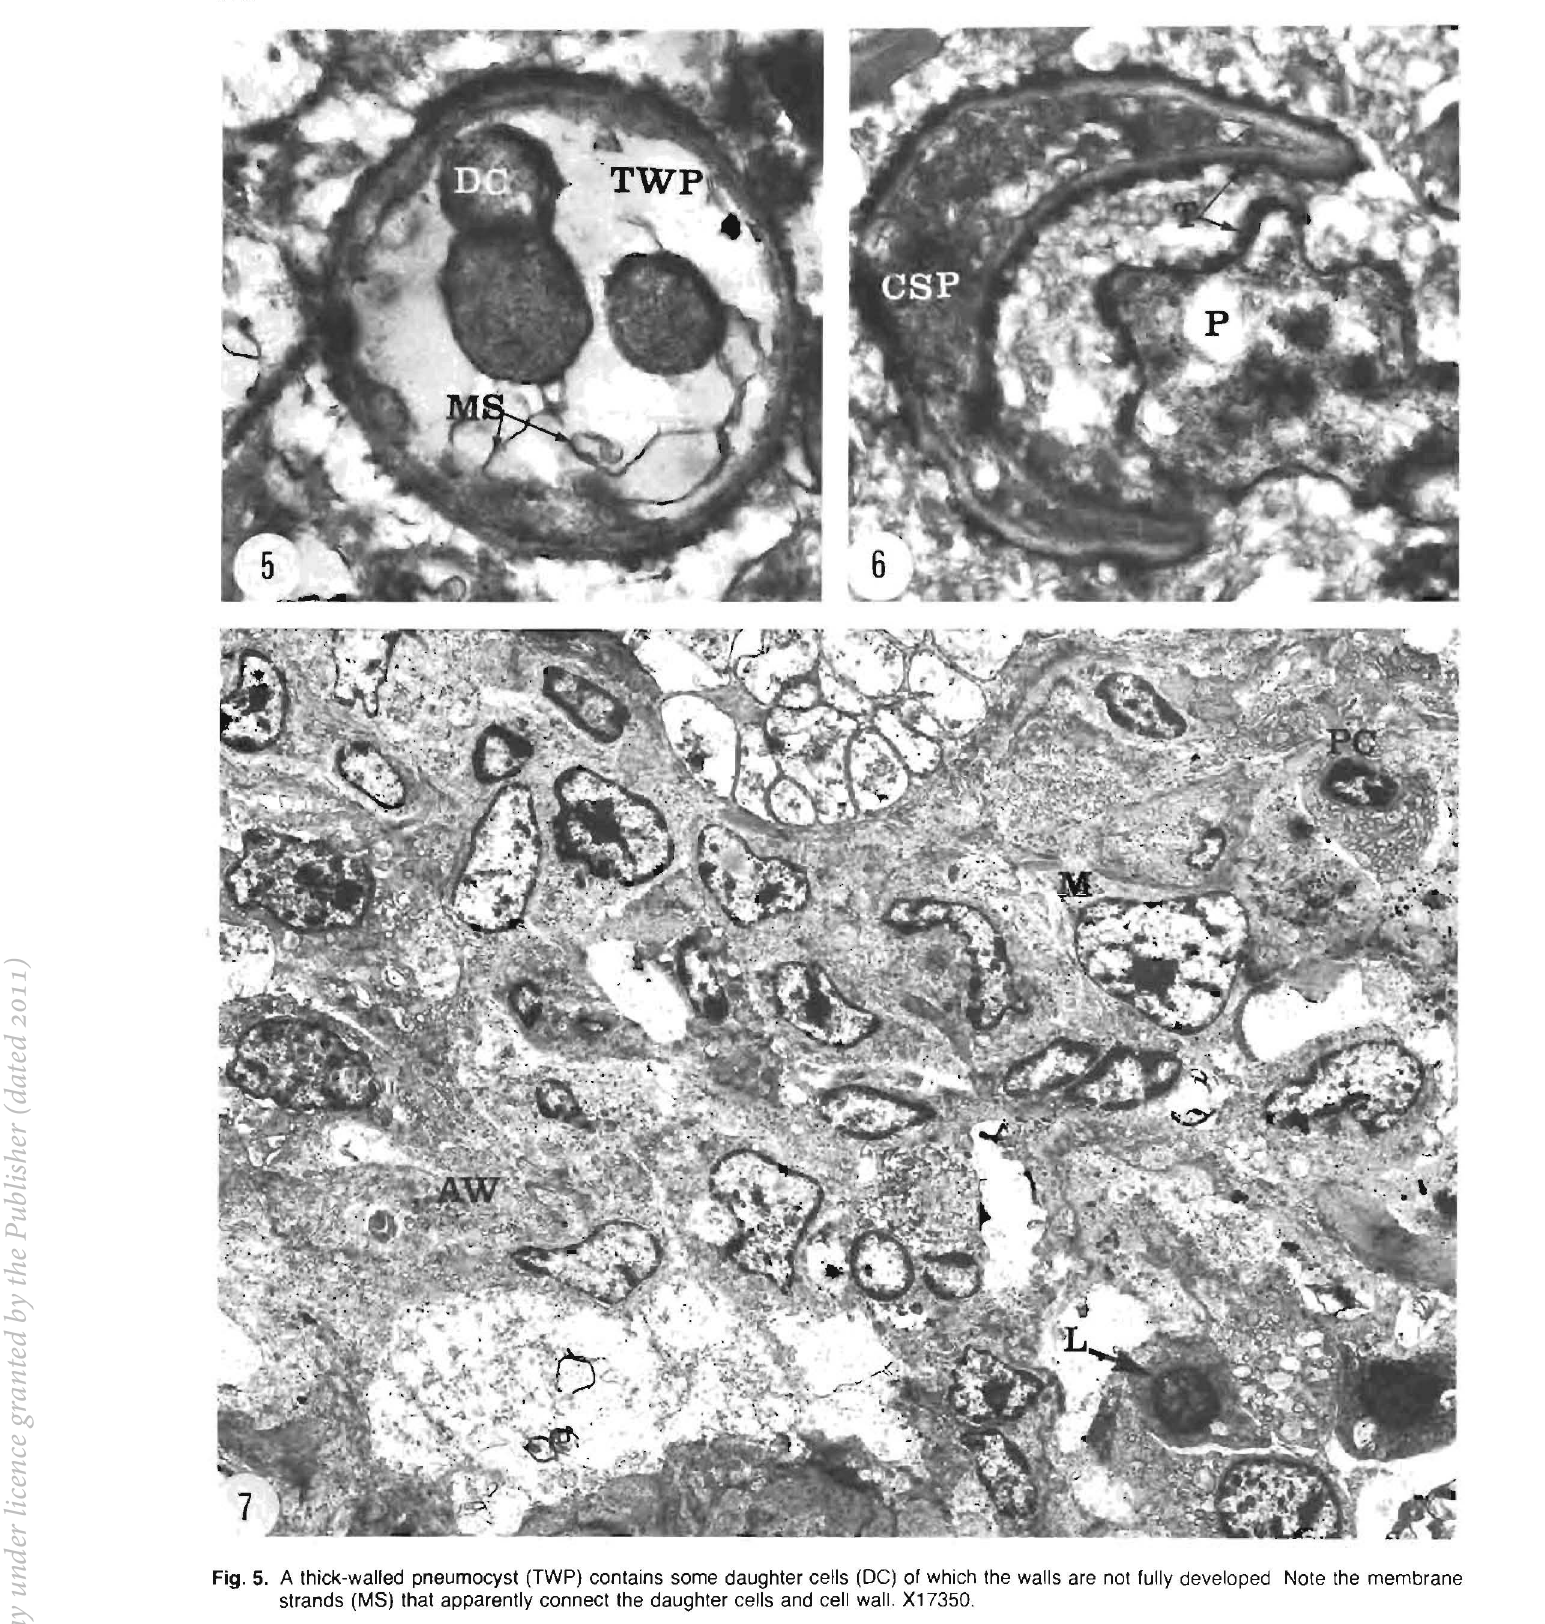
Fig. 5. A thick-walled pneumocyst (TWP) contains some daughter cells (DC) of which the walls are not fully developed Note the membrane strands (MS) that apparently connect the daughter cells and cell wall. X17350. Fig. 6. An apparently newly liberated thin-walled pneumocyst (P) and a collapsed crescent·shaped pneumocyst (CSP) Note the tubular expan sions (T) on the external part of the walls of both pneumocysts X21700 Fig. 7 The alveolar wall (AW) IS thickened and contains many Inflammatory cells Plasma cells (PC). macrophages (M) and lymphocytes (L) are present. X3100